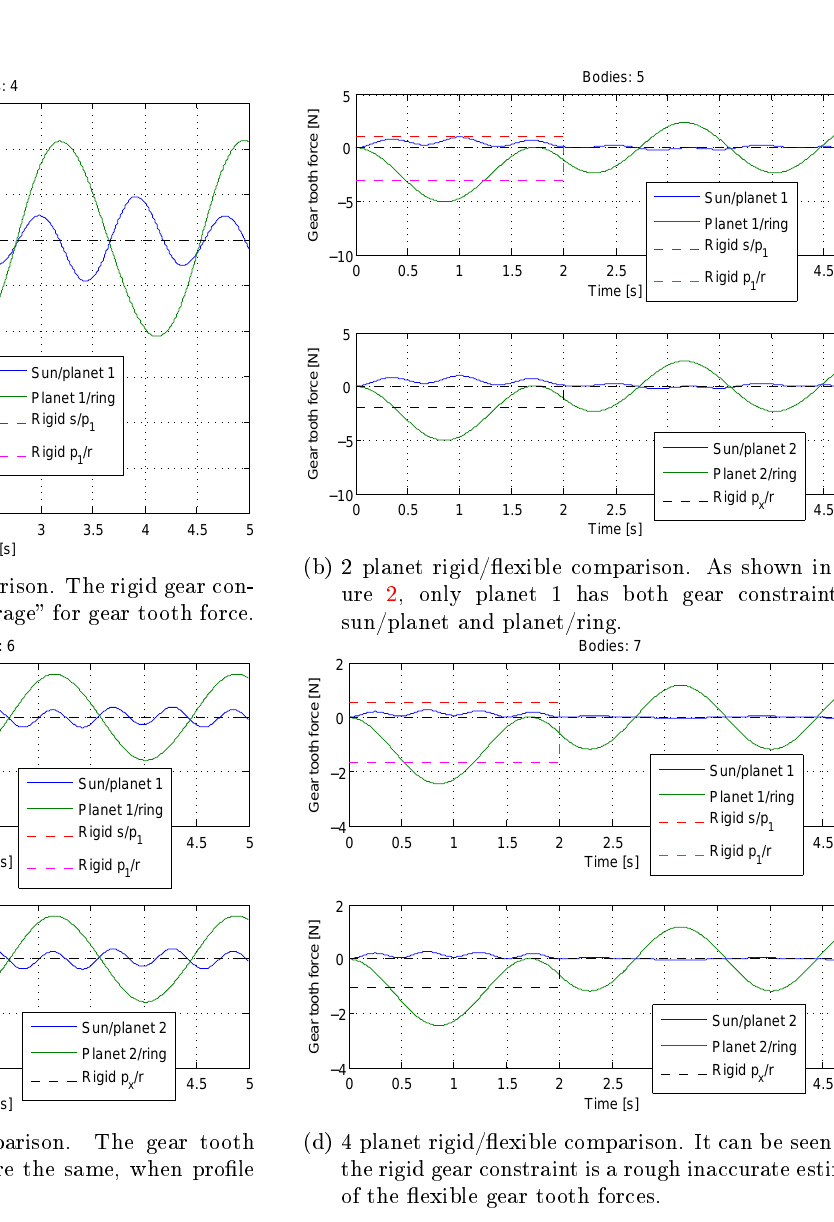
(c) 3 planet rigid/(cid:29)exible comparison. The gear tooth forces for planets 2 and 3 are the same, when pro(cid:28)le shift x = 0 . Figure 9: Gear tooth forces for the rigid vs. (cid:29)exibly-connected arti(cid:28)cial planetary multibody gearbox model with 1-4